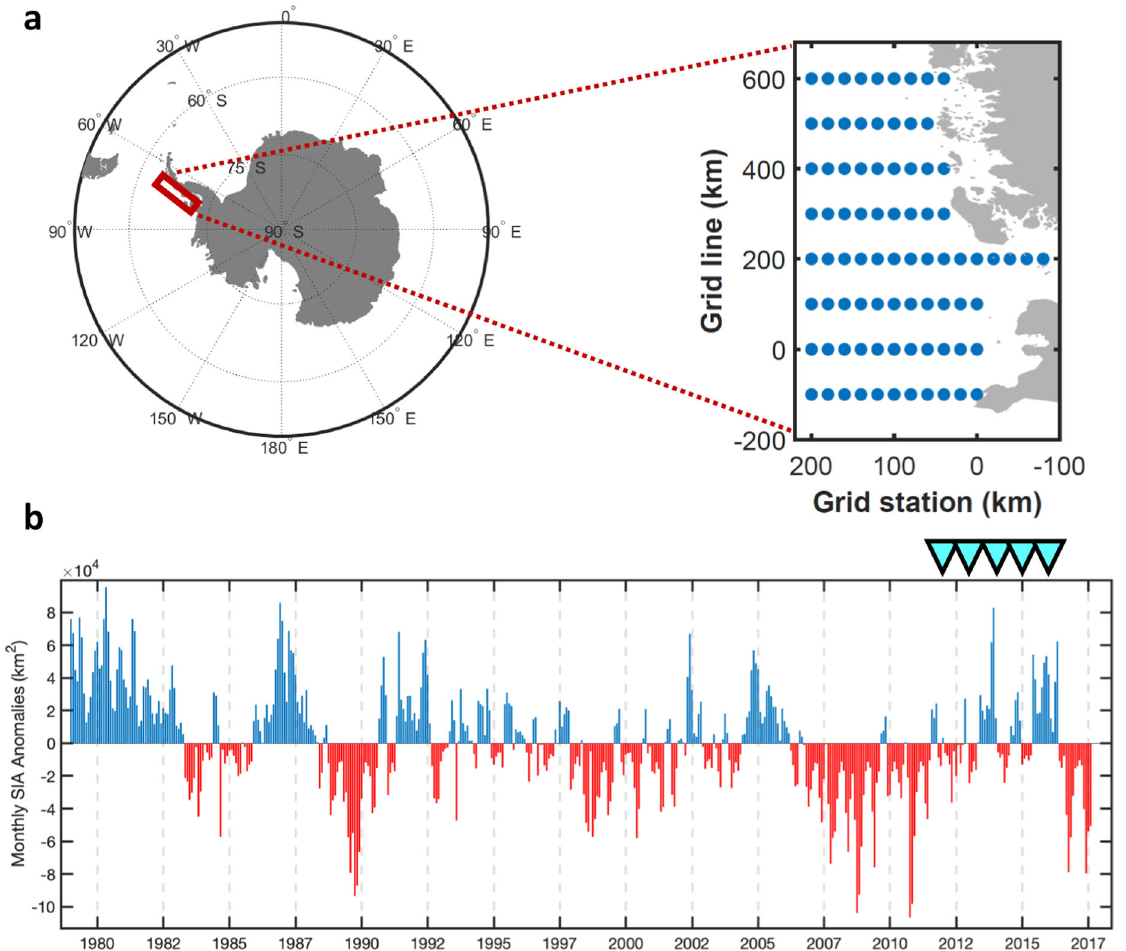
Fig. 1 Monthly sea-ice area anomalies at the WAP. a Location of the study area (red box) and the Palmer LTER sampling grid with hydrostations (blue dots). b Time-series of monthly averaged sea-ice area (SIA) anomalies for Palmer LTER sampling area from 1979 to 2017. Blue (red) bars represent negative (positive) SIA compared to a 39-year climatology for a particular month. SIA data were downloaded from Palmer LTER DataZoo (http://pal. lternet.edu/data). Cyan arrows highlight the sampling periods in this